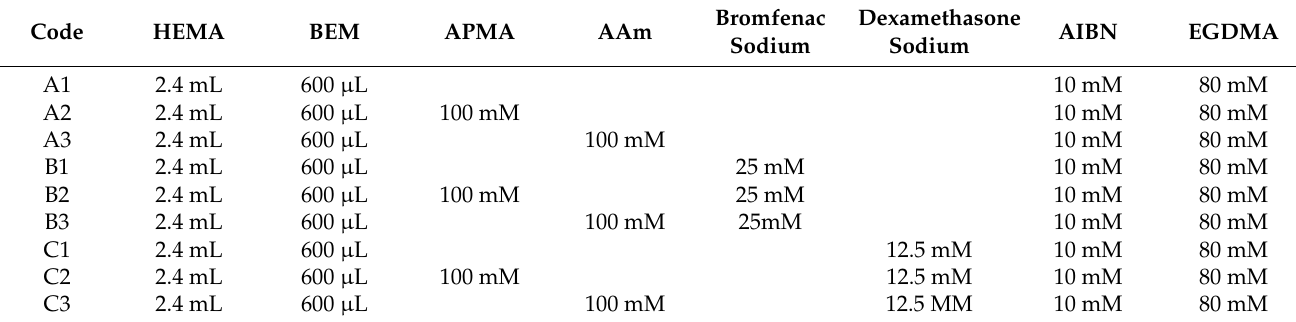
Table 1. Composition of the nine formulations tested as potential IOL materials. A1, A2 and A3 are non-imprinted hydrogels. B1, B2, B3 are bromfenac-imprinted hydrogels. C1, C2 and C3 are dexamethasone-imprinted hydrogels. Code HEMA BEM APMA